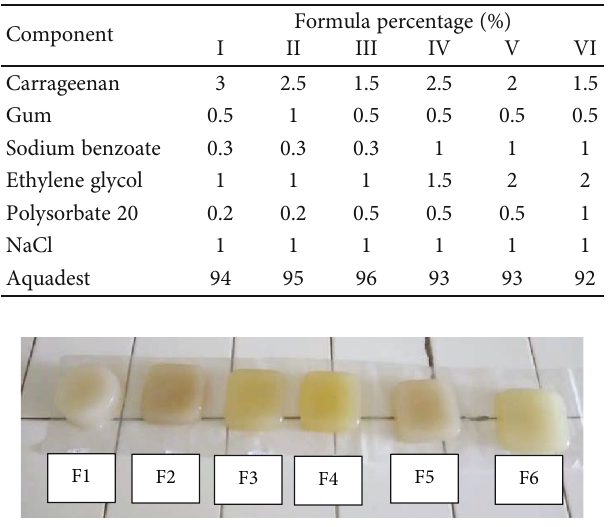
Figure 1: Six formulations of air freshener gel.